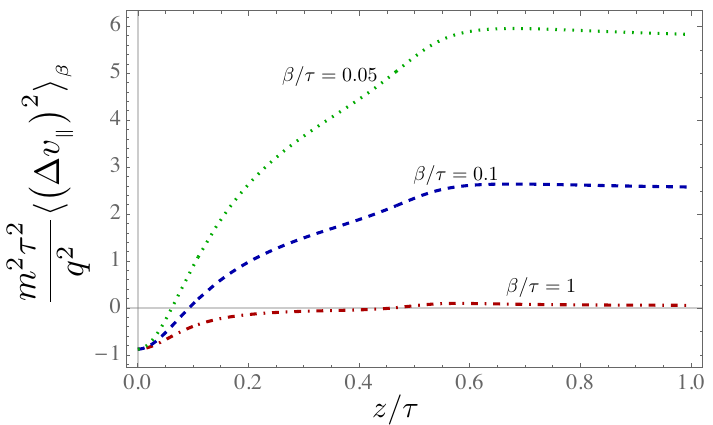
Figure 8 . Behaviour of the parallel component of the dispersion near the wall. Notice that the magnitude of the dispersion in the limit of z (cid:12)gure we choose (cid:28) s =(cid:28) = 0 : 1.